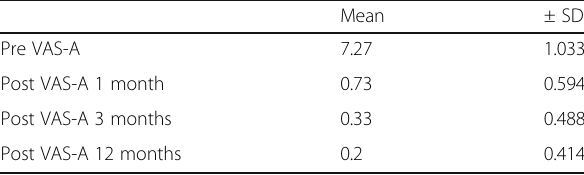
Table 6 Comparison between preoperative VAS-A and at different follow-up intervals among DCI group